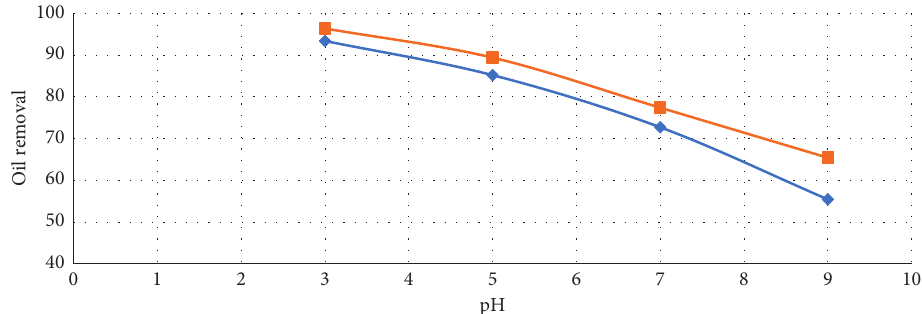
Figure 4: pH effect on removal of PW using TiO